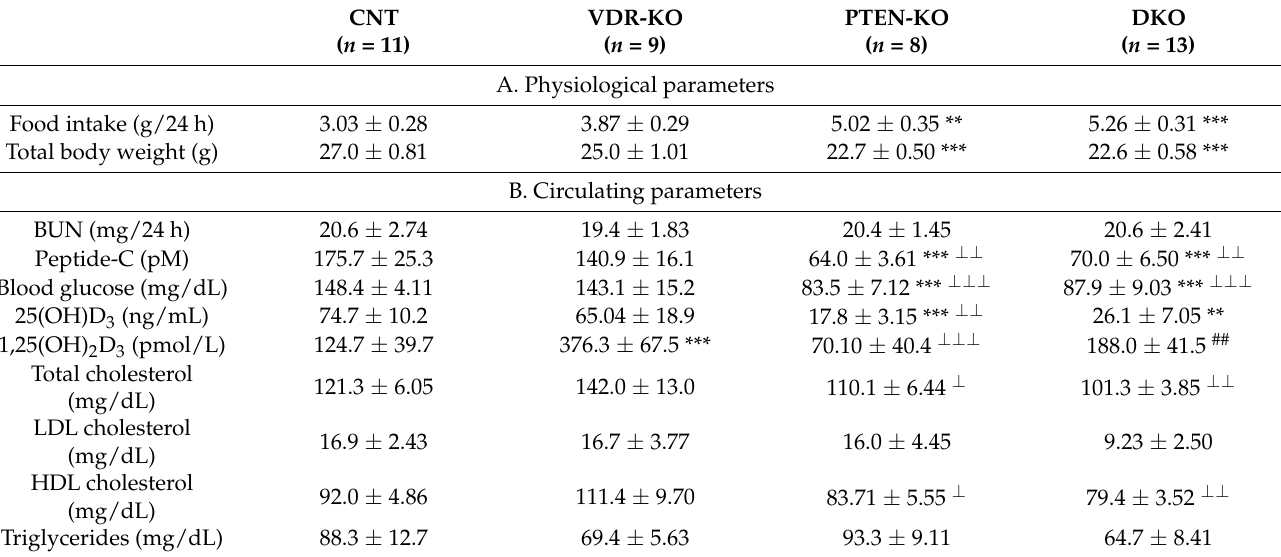
Table 1. Physiological and serum